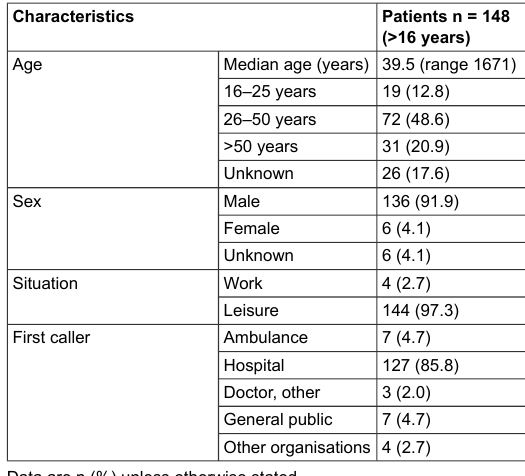
Table 1: Demographics and characteristics of all patients (regardless of feed- back, n = 148).